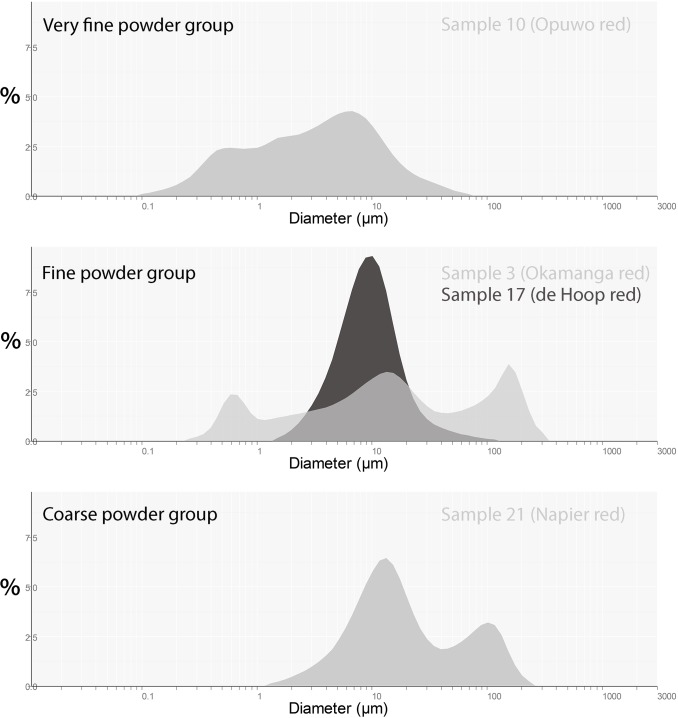
Representative grain size distributions for each group.